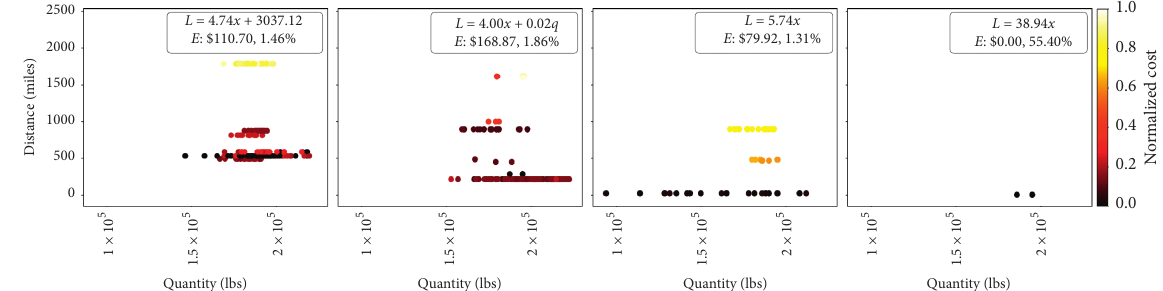
Figure 9: Distance versus quantity scatter plots for train carriers. Color indicates freight cost (key on right), normalized to [0, 1] for each carrier to have a minimum cost of 0 and a maximum cost of 1. Cost equations are obtained by performing regression analysis on each carrier. Weights are constrained to have positive values. In each cost equation (inset), L indicates the cost equation of the carrier, x denotes the distance in miles, q denotes the quantity in pounds, and E denotes the absolute error of the cost regression in dollars and as a percentage. Carrier names are omitted to preserve anonymity.